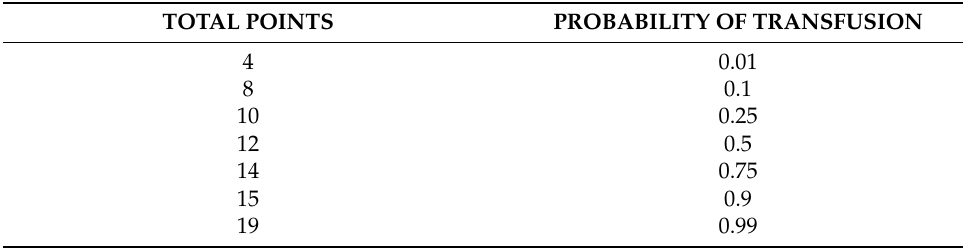
Table A9. Probability of